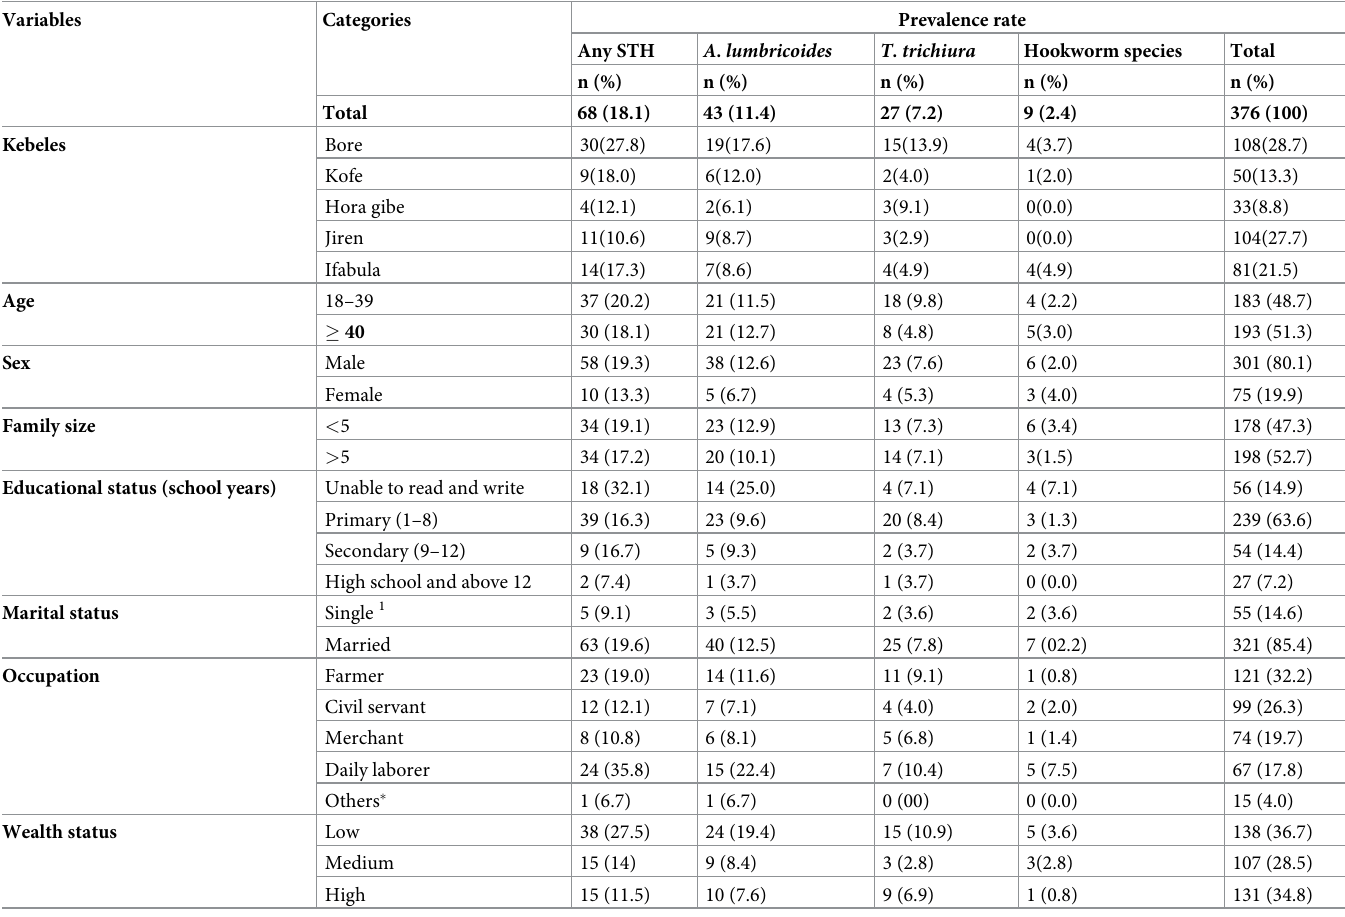
Table 1. Prevalence of STH and its distribution by socio-demographic characteristics of the household heads in the peri-urban area of Jimma town, Oromia, Ethio- pia, May to July 2021 (n = 376).